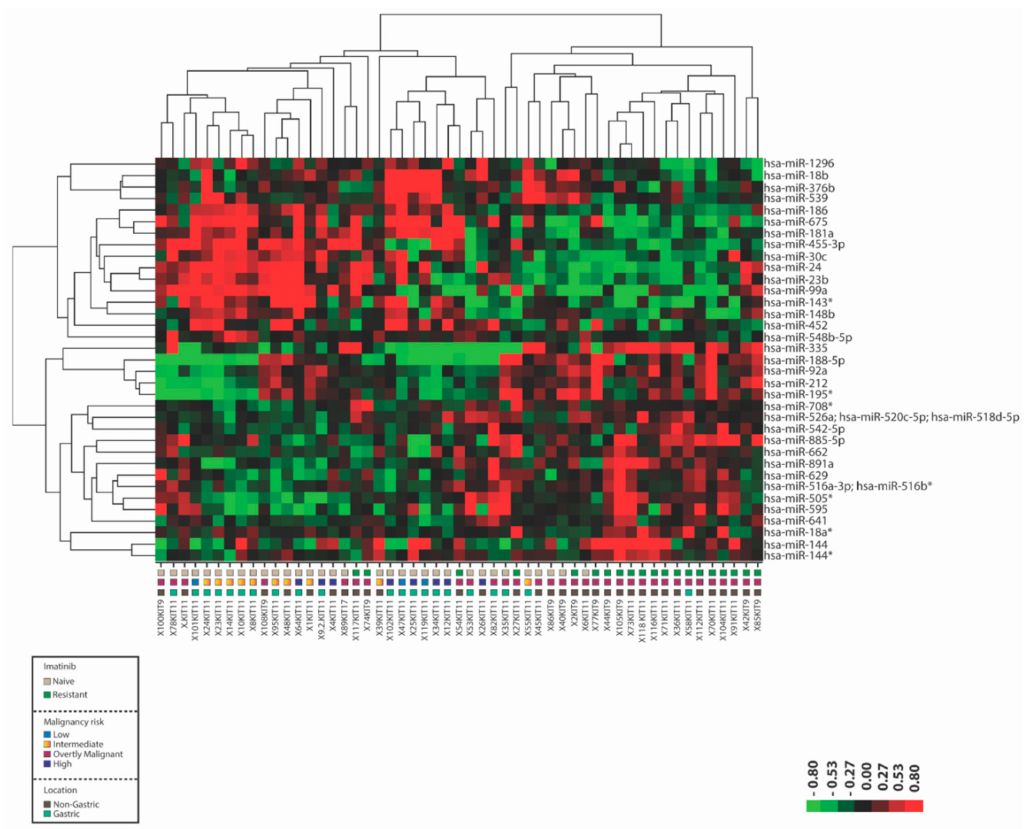
Figure 1. MicroRNA expression distinguishes imatinib-naïve (IM-n) from imatinib-resistant (IM-r) gastrointestinal stromal tumors (GIST). Fresh frozen tumor samples of IM-n and IM-r GIST patients were subjected to miRNA expression profiling. Depicted is the heat map of a supervised hierarchical clustering based on the 35 most significant ( p < 0.01 and False Discovery Rate (FDR) < 20%) di ff erentially expressed miRNAs. In the heat map red indicates relative high expression and green indicates relative low expression. The colored squares beneath the graph designate IM-n and IM-r samples, the malignancy risk and location of the tumors. Note that the sample codes below also indicate which KIT exon is